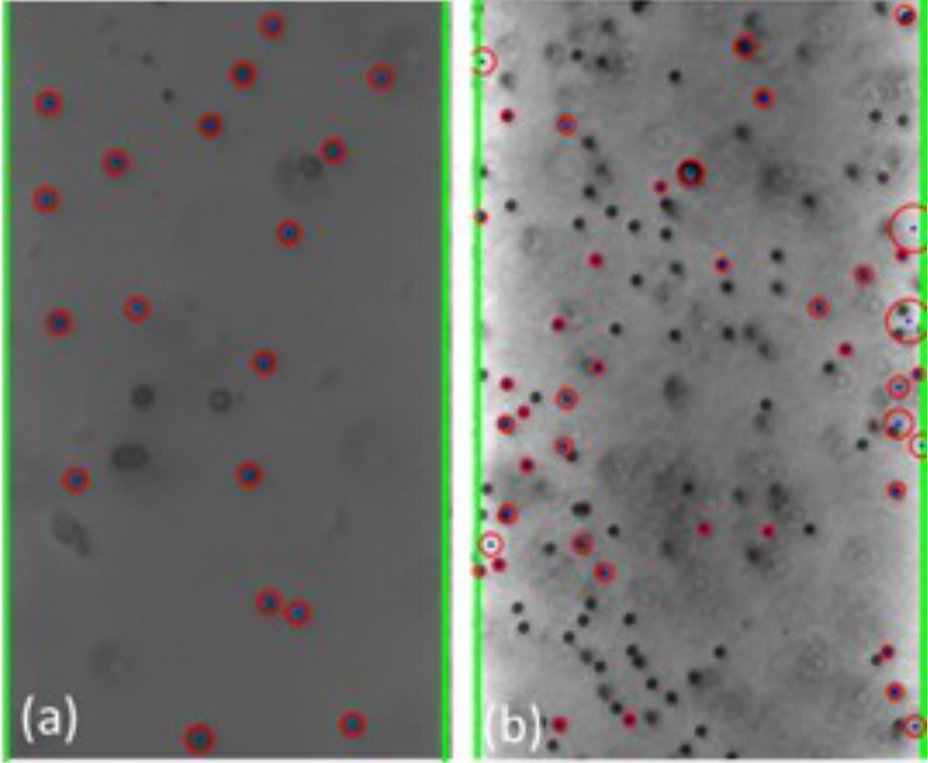
Figure 5. Different bead detection efficacy between samples ( a , b ) depended on bead size and illumination conditions.